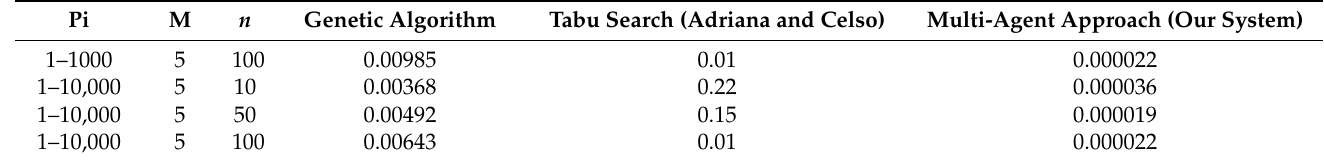
Table 3. Comparison of the execution time of our system with genetic and tabu search algorithms. Tabu Search (Adriana and Celso) Multi-Agent Approach (Our